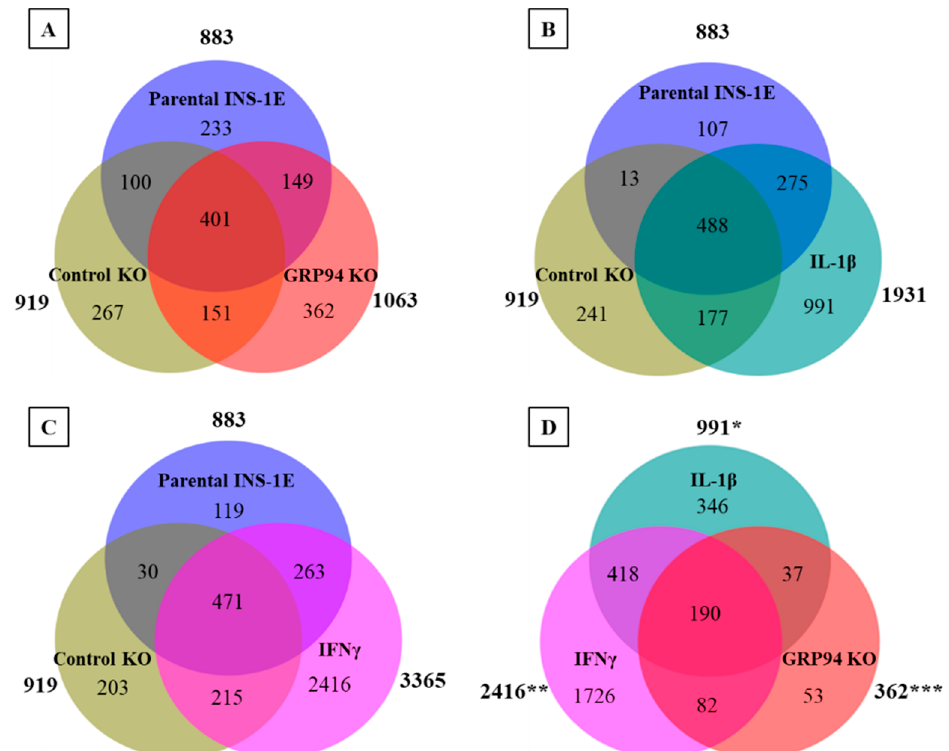
Figure 3. Venn diagrams showing number of MHC I-eluted peptides distinct or overlapping between ( A ) parental INS-1E, control KO & GRP94 KO, ( B ) parental INS-1E, control KO & IL-1 β exposure (15 pg/mL for 24 h), ( C ) parental INS-1E, control KO & IFN γ exposure (10 ng/mL for 24 h), and ( D ) Peptides exclusive for IL-1 β , IFN γ -exposed and GRP94 KO INS-1E groups. n = 2 for all except GRP94 KO where n = 4. * IL-1 β peptides excluding parental INS-1E and control KO clone; ** IFN γ peptides excluding parental INS-1E and control KO clone; *** GRP94 KO peptides excluding parental INS-1E and control KO clone.